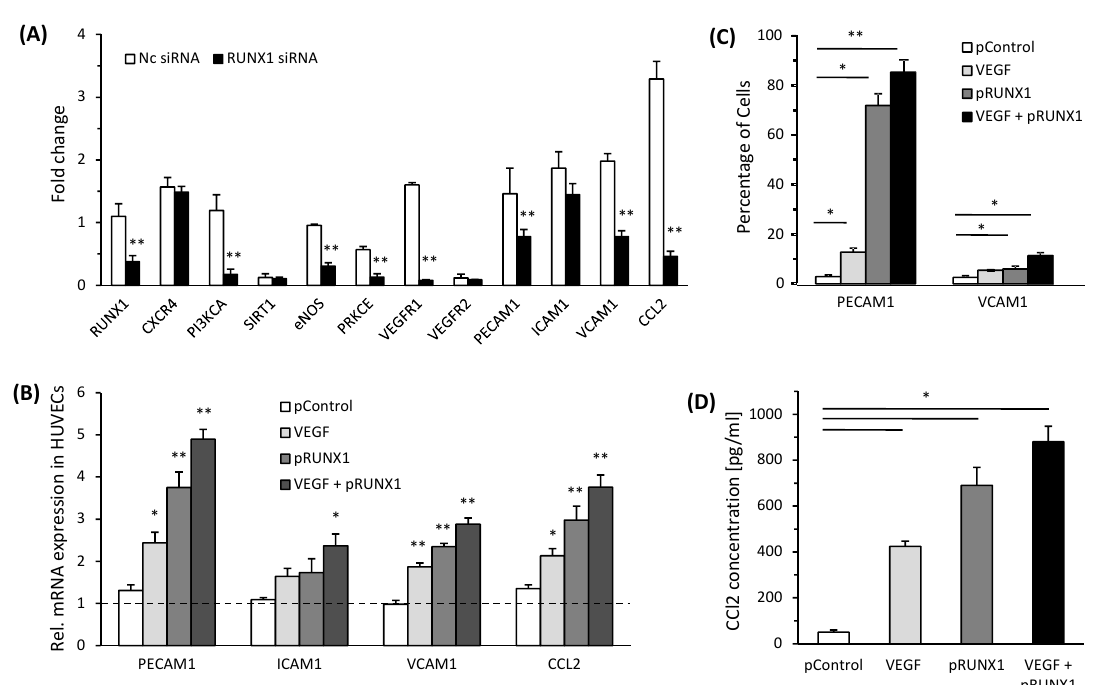
Figure 4. RUNX1 alters expression of angiogenic and adhesion molecules in endothelial cells ( A ) HUVECs, treated with RUNX1 siRNA or NC siRNA and incubated with CM from PA-Huh7 cells, were analyzed for mRNA expression (fold change) of angiogenic, adhesion molecule and RUNX1 target genes ( n = 3). ( B ) HUVECs transfected with RUNX1 expression plasmid (pRUNX1), control plasmid (pControl, i.e., empty vector) and / or incubated with VEGF (10 ng / mL) were analyzed for mRNA expression of adhesion molecule and chemotactic genes. HUVECs without any treatment were used as respective controls (Dotted line) ( n = 3). 18S RNA expression was used for normalization. ( C ) Quantitative analysis of flow cytometry from ( C ) is shown ( n = 3). ( D ) CCL2 levels (pg / mL) in culture media of HUVECs transfected with RUNX1 expression plasmid (pRUNX1), control plasmid (pControl, empty vector) and / or incubated with VEGF (10 ng / mL) ( n = 4). Data represent mean ± SD. * p < 0.05 and ** p <